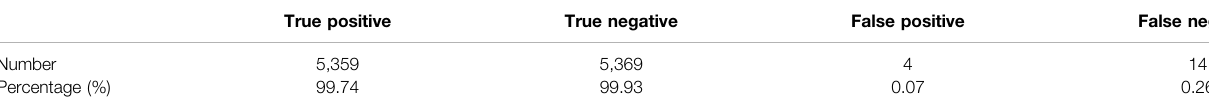
TABLE 3 | Identi fi cation of results on the testing set.